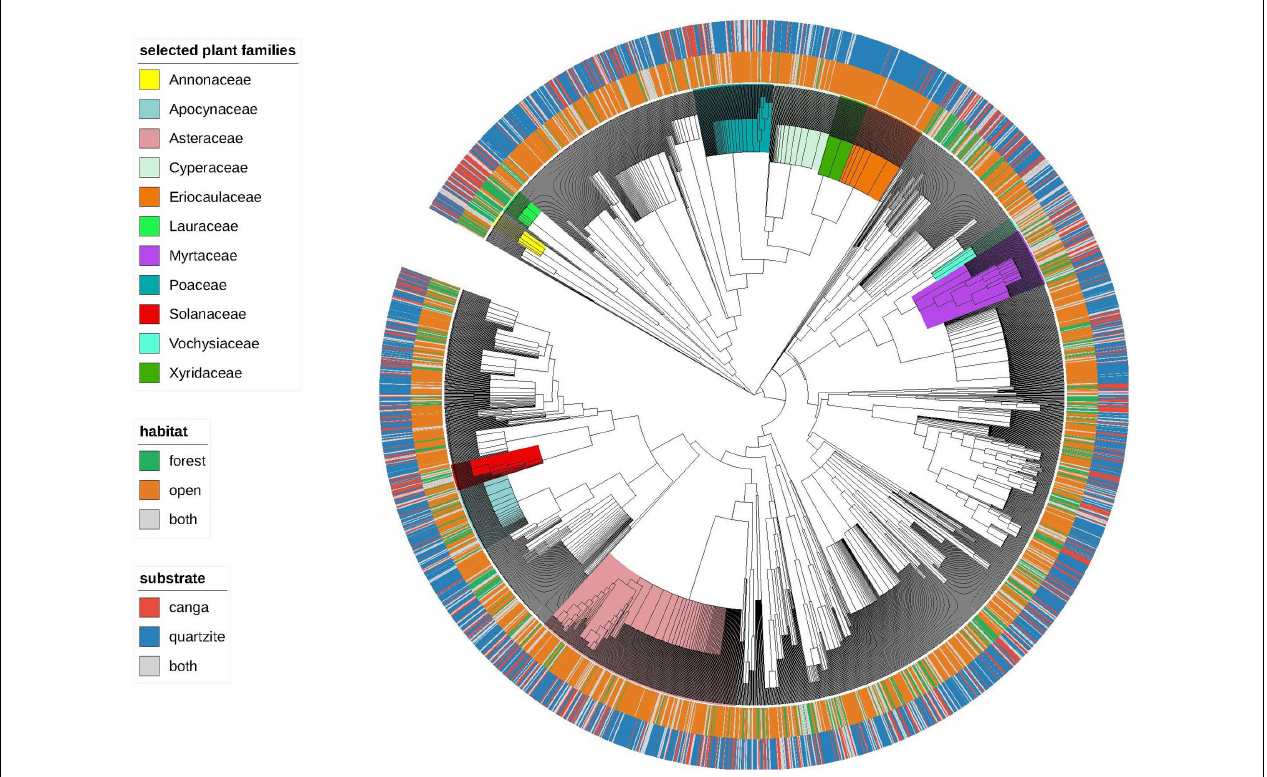
FIGURE 3 | The “Espinhaço megatree” indicating vegetation and substrate affinities for the 2920 species. Plant families mentioned in the results and discussion are